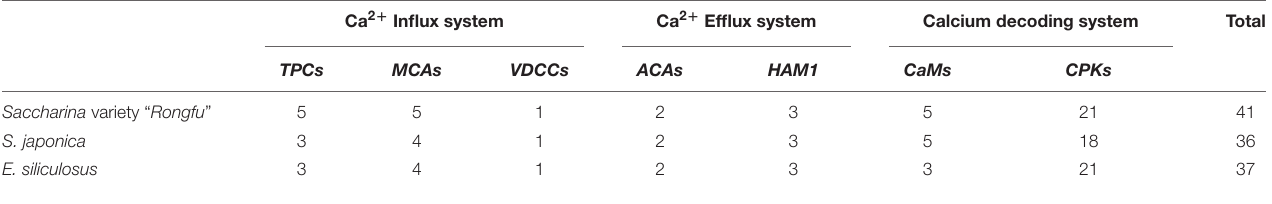
TABLE 6 | Gene number of the calcium-based signaling system in sequenced Saccharina variety “Rongfu,” S. japonica and E. siliculosus . Ca 2 + Influx system Ca 2 + Efflux system Calcium decoding system